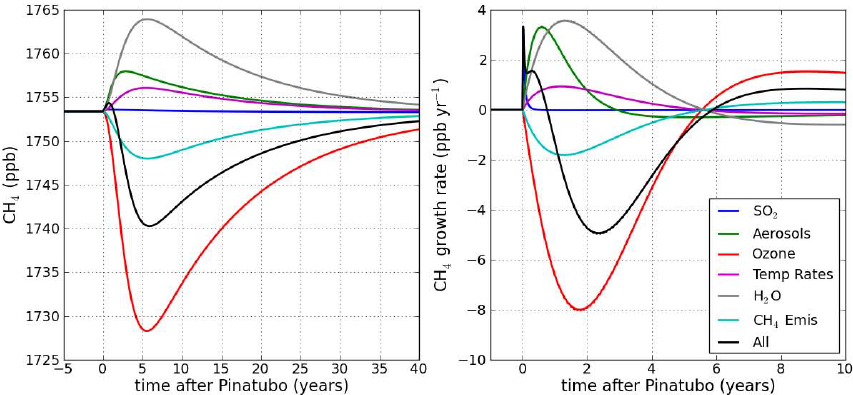
Fig. 6. Effect of the different Pinatubo forcings on the temporal evolution of the tropospheric mean CH 4 mixing ratio and growth rate.